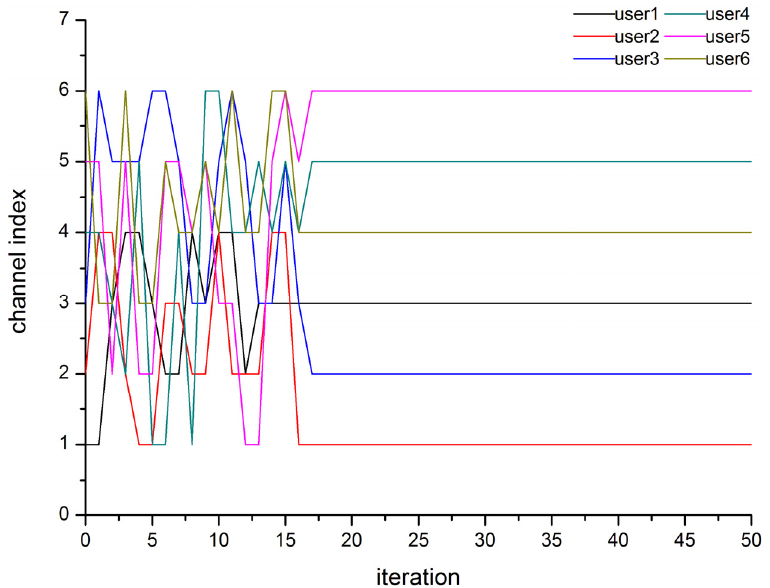
Figure 8. The simulation results of proposed CR spectrum allocation algorithm based on non-cooperative game theory with six